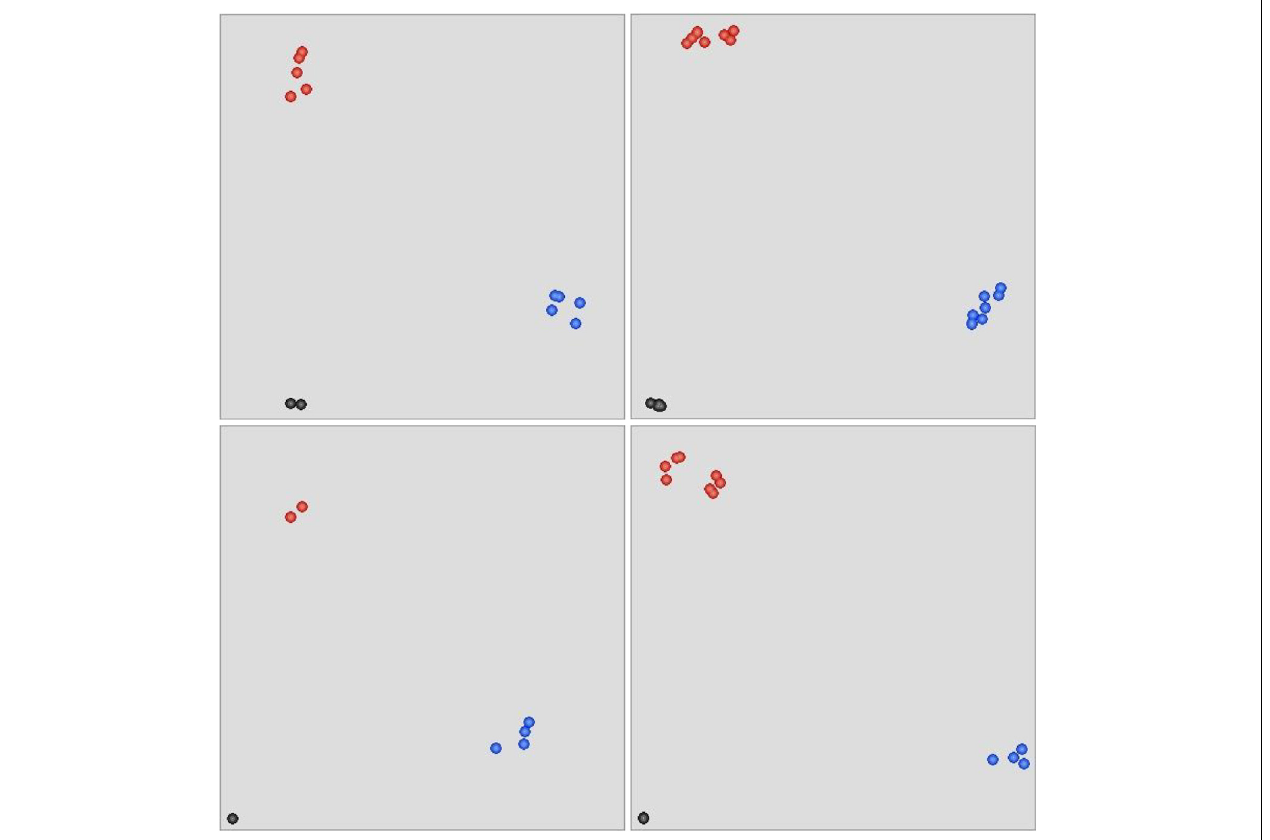
FIGURE 6 | Scatter plot of KASP assay for genotyping selected SNPs. The blue-colored dots represent alleles with FAM tails. The HEX-tailed allele is indicated by red dots. Black dots reflect the negative control or alleles yielding no PCR products. All 26 SNPs were genotyped with four KASP assays.